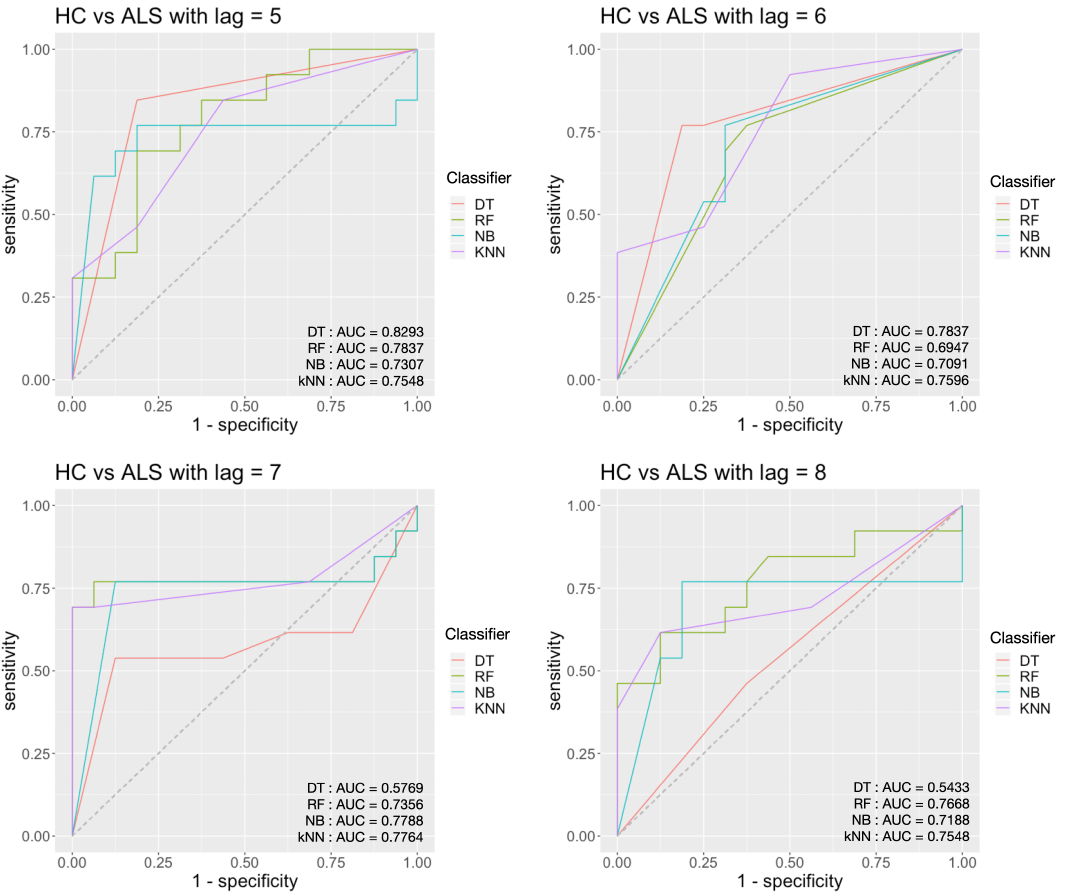
Figure 11. Classification results for HC vs. ALS with an embedding time delay lag of 5, 6, 7 and